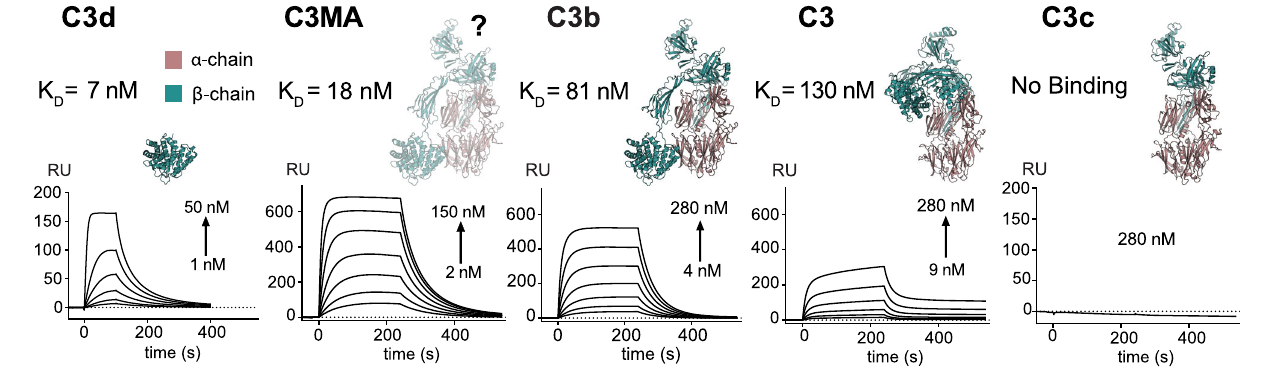
Fig.5|ISG65bindsproteolyticfragmentsofC3withdifferentaf fi nities. Surface plasmon resonance sensorgrams showing the kinetics of ISG65 binding to C3d, C3MA,C3b, native C3,andC3c(from leftto right).Increasing concentrationsof C3 analytes were injected into the sensor chip, to which C-terminally biotinylated ISG65 (ligand) was immobilised. Structures of C3 fragments are shown above the